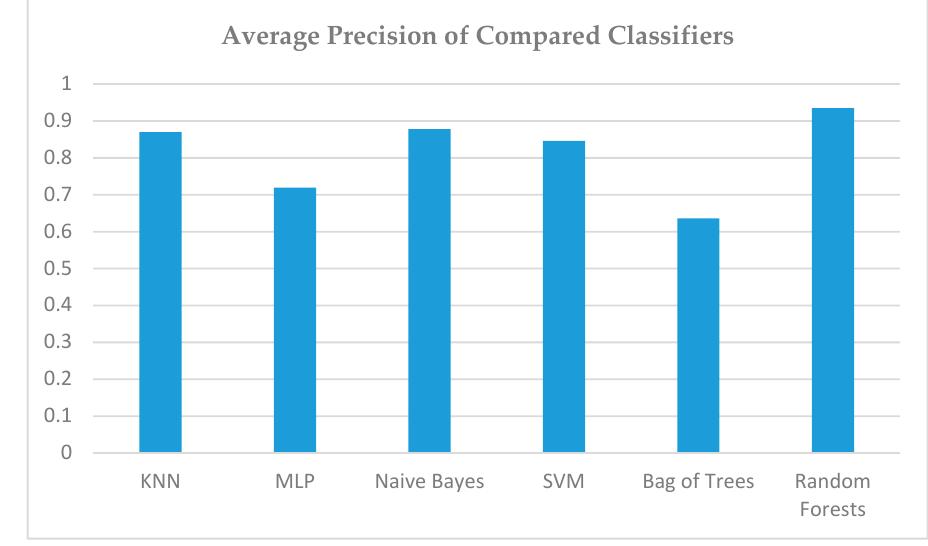
Figure 9. Comparison of Precision of all Classifiers.